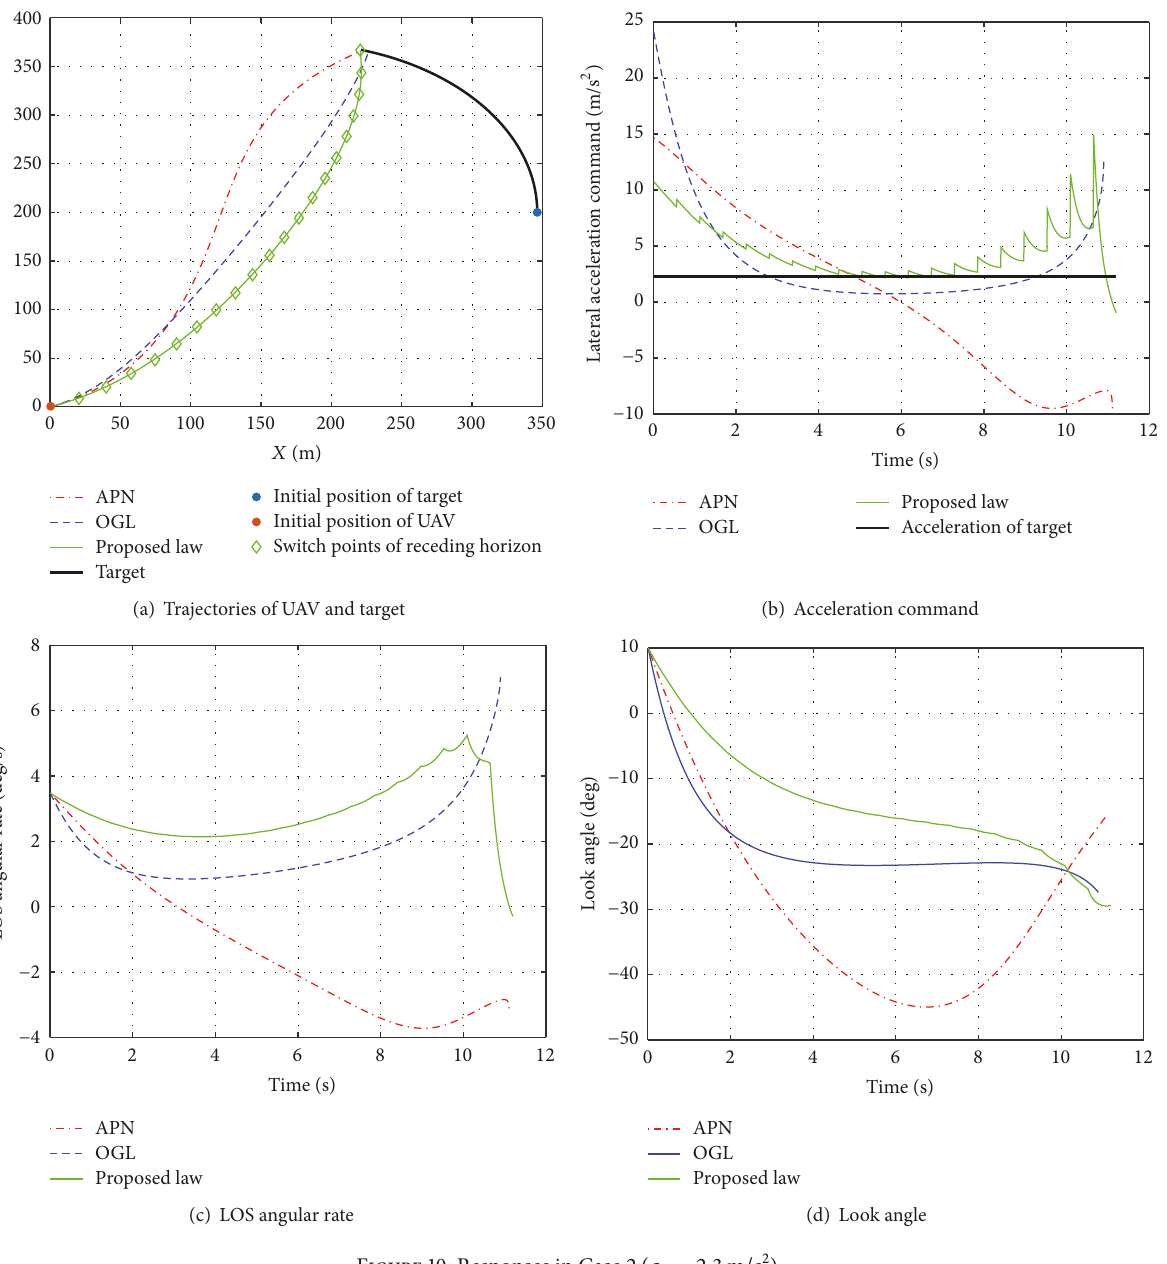
Figure 10: Responses in Case 2 (𝑎 𝑇 = 2.3 m / s 2 ) .